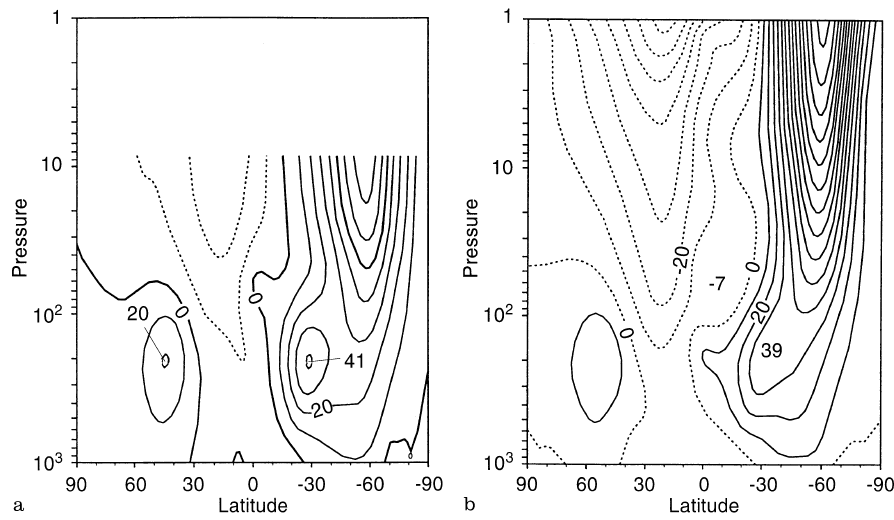
Fig. 1a, b. Zonal mean of zonal wind for July for a the ECMWF climatology and b the reference experiment REF31; contour interval 10 m s (cid:255)